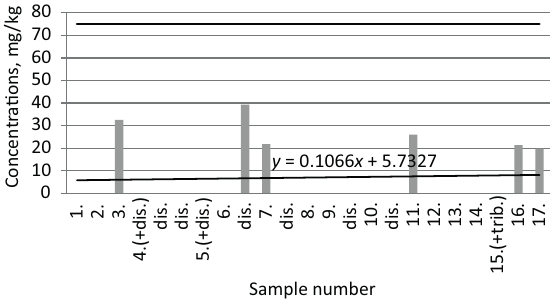
Fig. 10. Cu concentrations on the left bank, downstream trend ( y ), the concentration of the I sludge category (bold line)